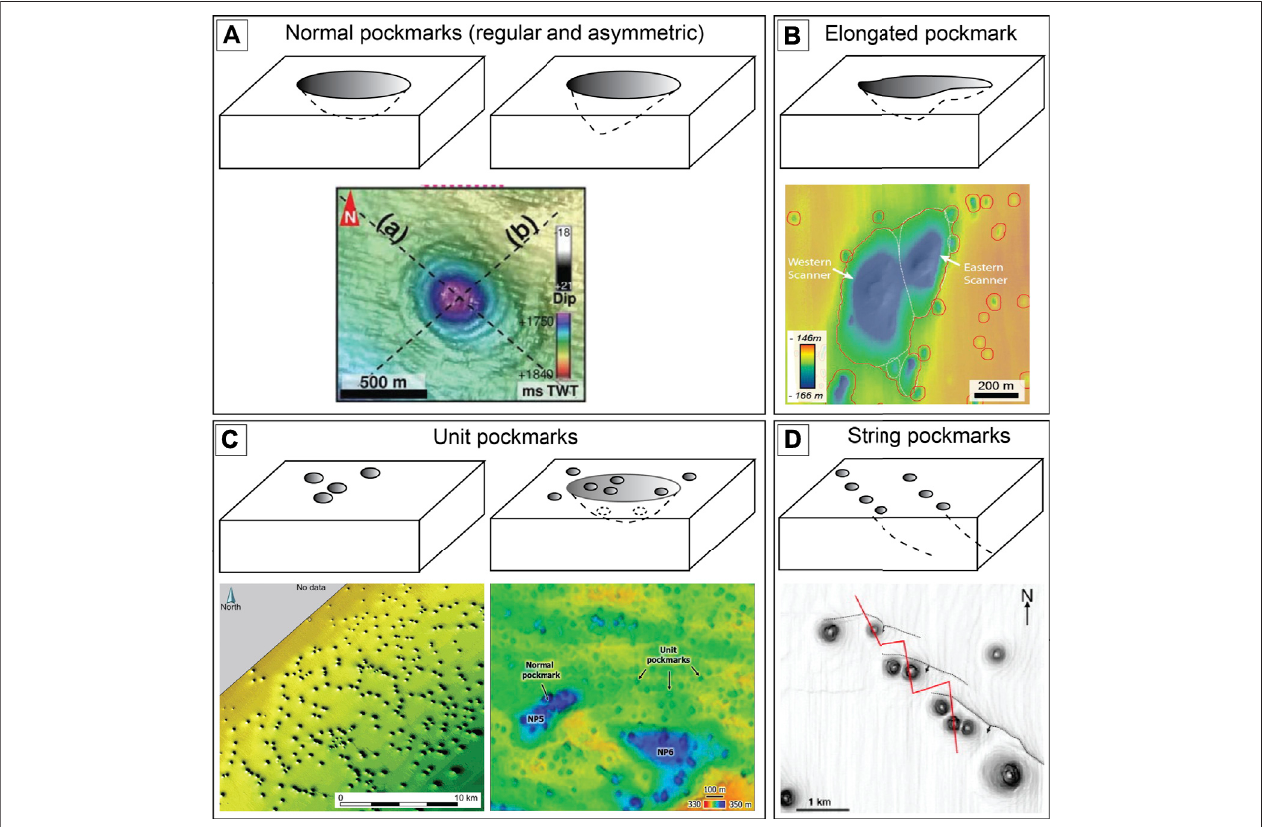
FIGURE 1 | The main classes of pockmarks are modi fi ed from Hovland et al. (2002). (A) Normal pockmarks, including regular and asymmetric shapes, and a top view of a normal pockmark (Ho et al., 2018); (B) top view of an elongated pockmark (Gafeira et al., 2018); (C) perspective view of unit pockmarks, with and without a “ parental ” normal pockmark (de Mahiques et al., 2017; Tasianas et al., 2018); and (D) top view of string pockmarks (Pilcher and Argent, 2007).